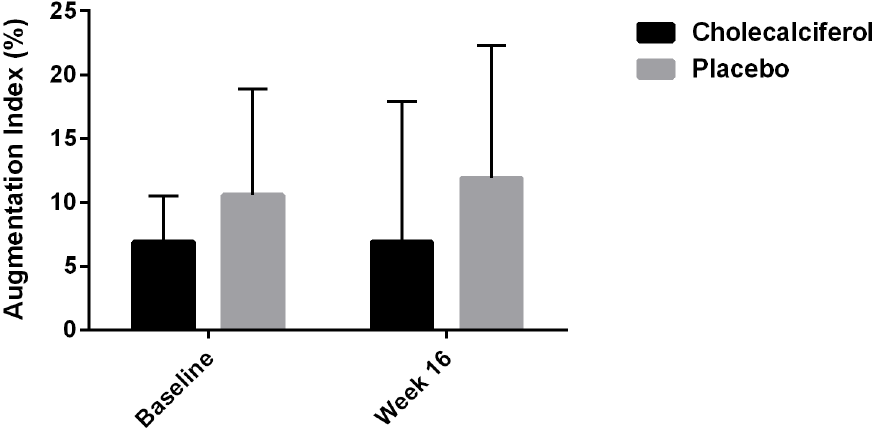
Fig 4. Treatment Effect on Augmentation